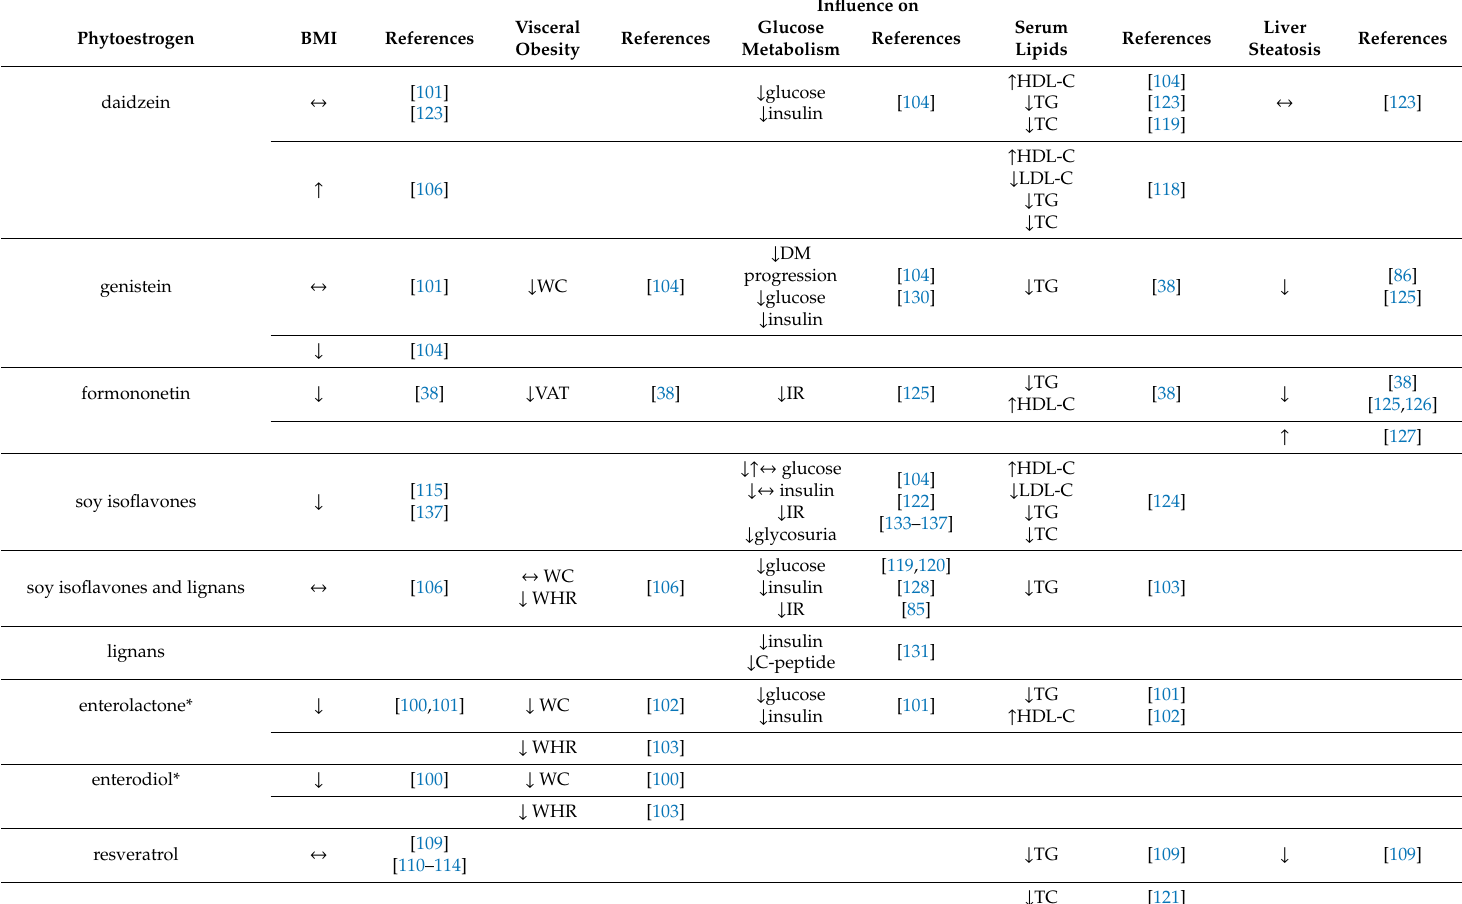
Table 2. Influence of dietary phytoestrogens on visceral obesity and its metabolic